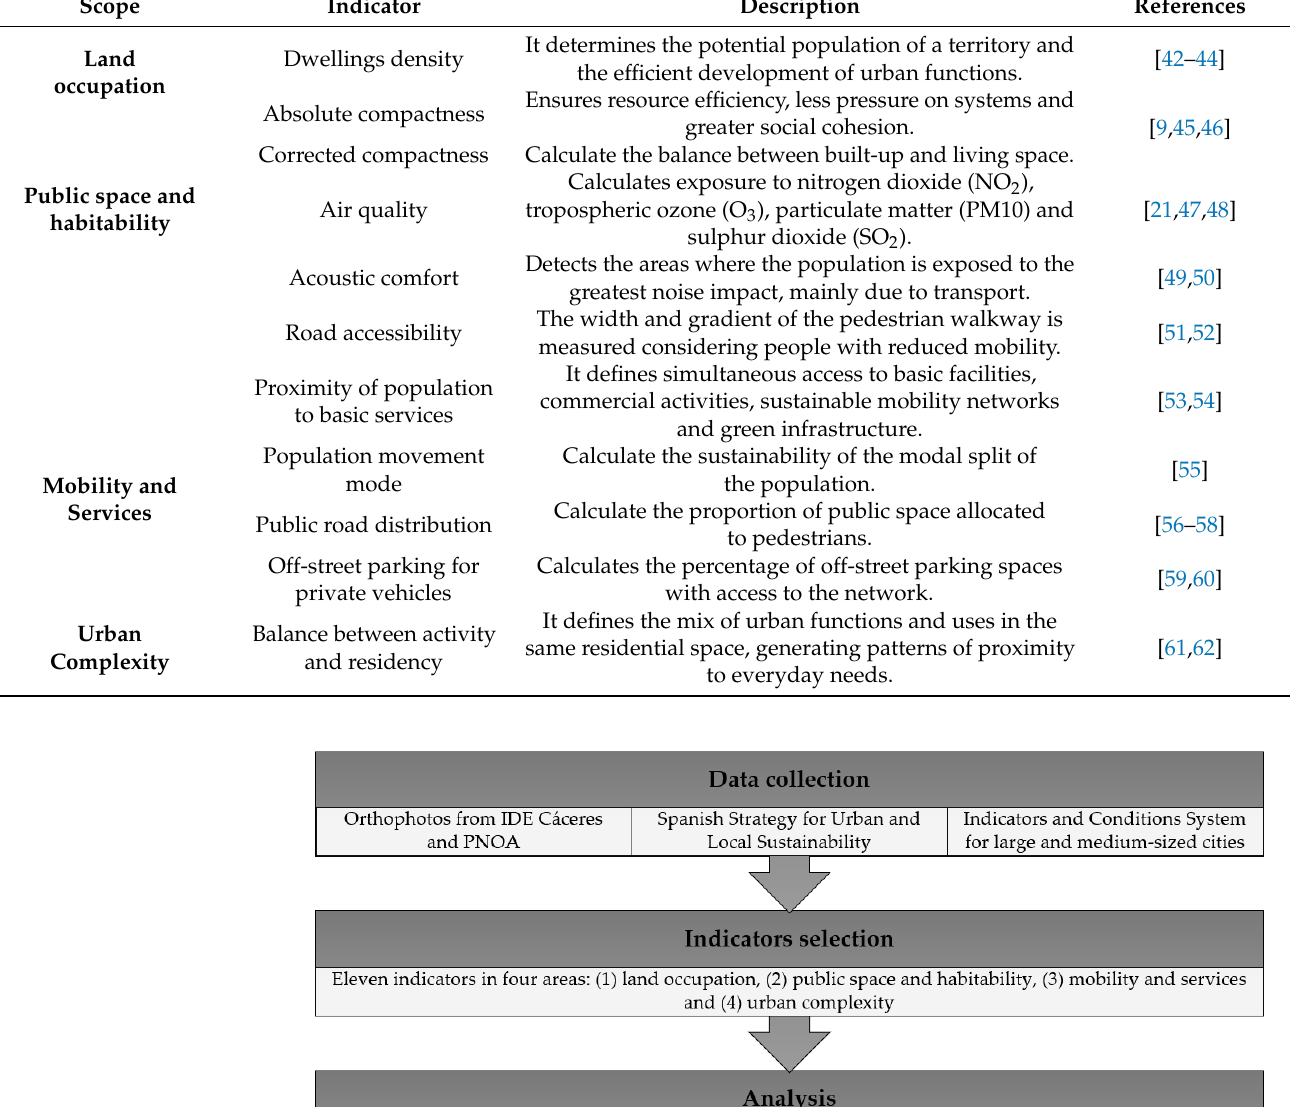
Table 1. Study indicator system.